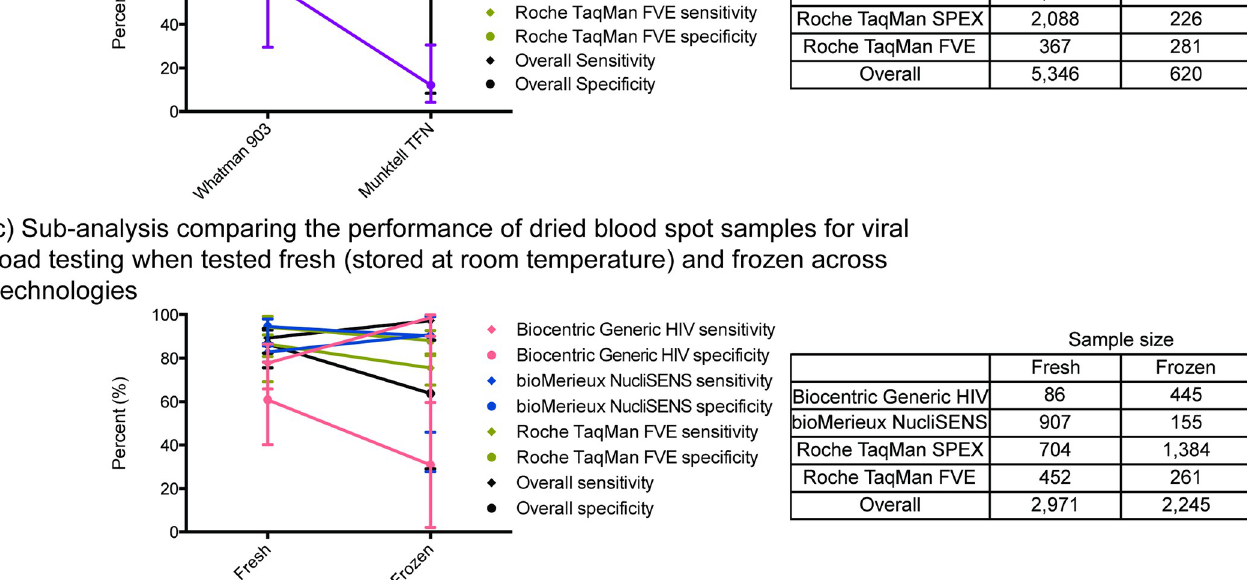
PLOS Medicine| https://doi.org/10.1371/journal.pmed.1004076 August 22,